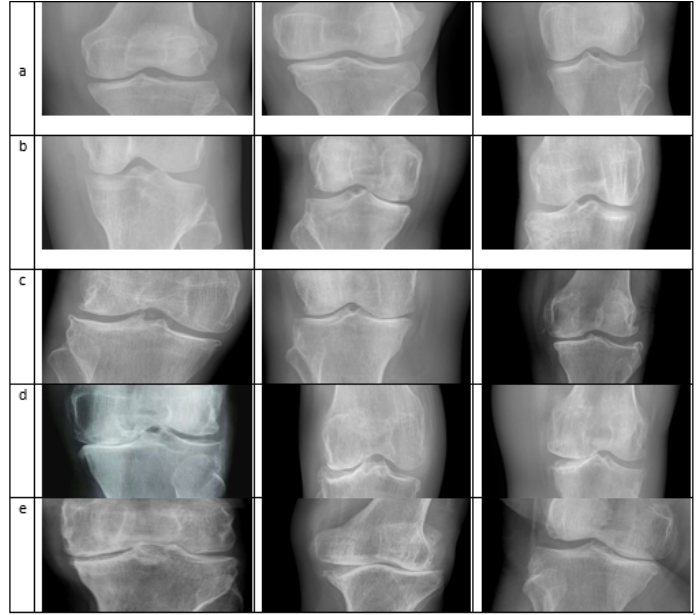
Figure 4. Different images taken from the Dataset: row ( a ) Normal Images; ( b ) Doubtful Images; ( c ) Mild; ( d ) Moderate; ( e ) Severe